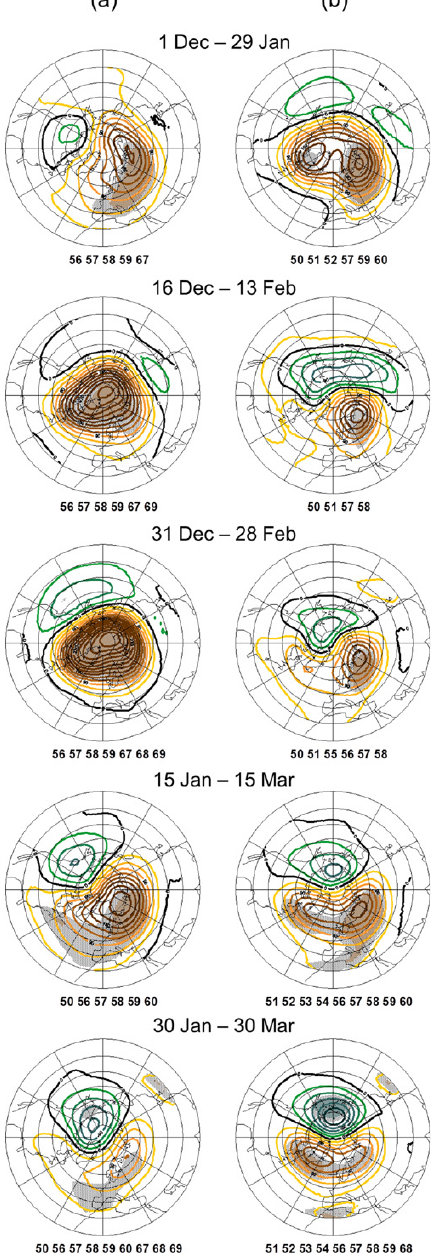
Fig. 2. Troposphere in the years 1950–1969. As in Fig. 1, but for geopotential level 850hPa. The contour interval is